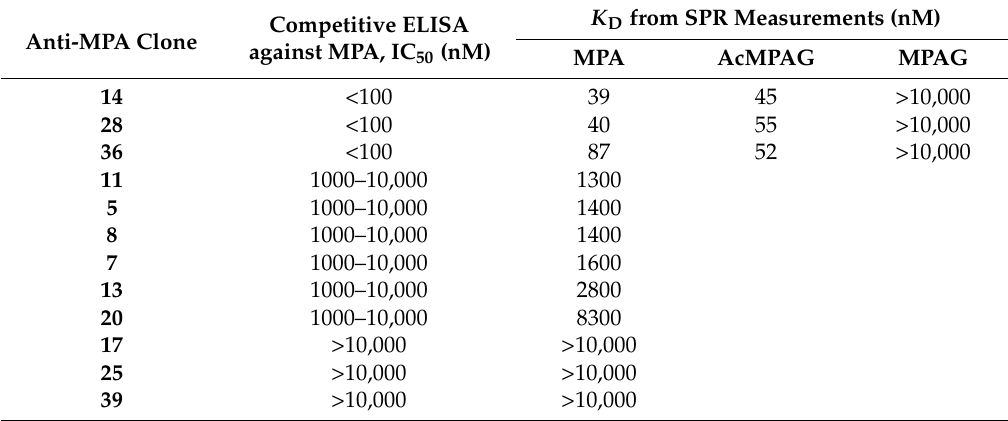
Table 4. Affinities and specificities of the anti-MPA antibodies measured by competitive ELISA and Surface Plasmon Resonance (SPR).